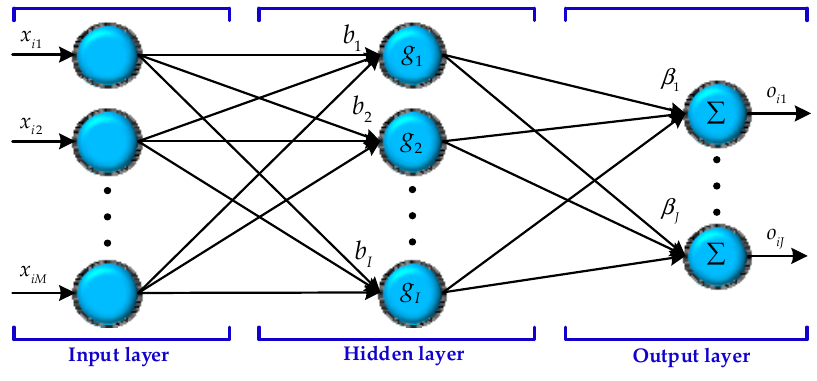
Figure 3. Architecture of the extreme learning machine.